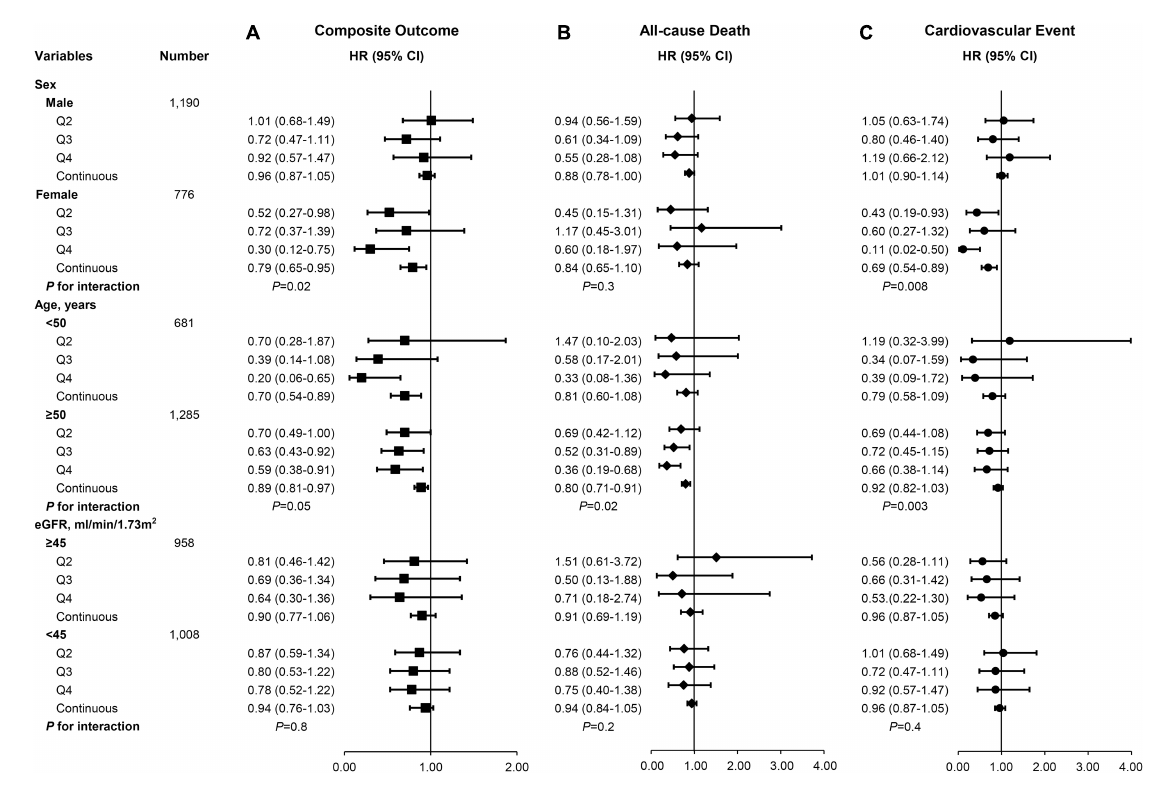
among subgroups by age and sex, but no interaction